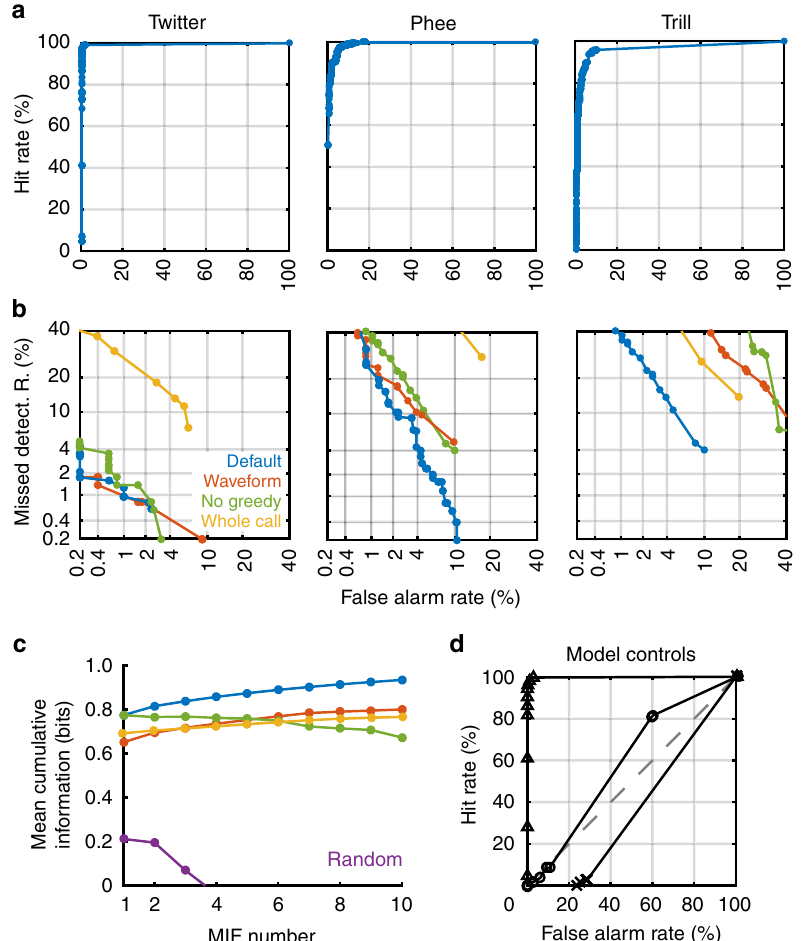
Fig. 6 Classi fi cation performance and controls. a Receiver operating characteristic (ROC) curves for the classi fi cation of twitters, phees, and trills using MIFs alone. b Detection error tradeoff (DET) curves comparing the default model (blue) to other model variations: (i) MIF-based classi fi cation with acoustic waveforms (red), (ii) feature selection without greedy search (green), and (iii) when entire calls are used as features (yellow). c Comparison between various model conditions (same as B) in terms of cumulative information added by each successive feature, averaged across all three call type classi fi cation tasks. Random (purple) is the classi fi cation of twitters using randomly selected features as MIFs, averaged across 20 trials. d ROC curves of three model controls: (i) classi fi cation of twitters when the model is trained on the twitters of 4 animals, and tested on twitters from 4 new animals (triangles), (ii) classi fi cation of twitters from other twitter calls (circles), and (iii) classi fi cation of twitters using trill MIFs